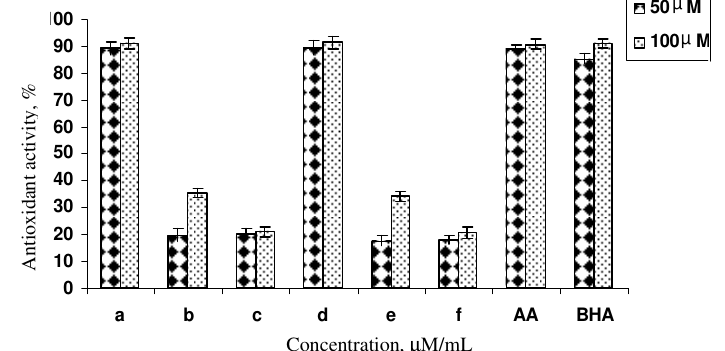
Figure 2. Antioxidant activity (%) of the dibenz[ b,f ]azepine and its derivatives at 50 µM and 100 µM concentration in β -Carotene-Linoleic acid system. Values are means of triplicate determination ± standard